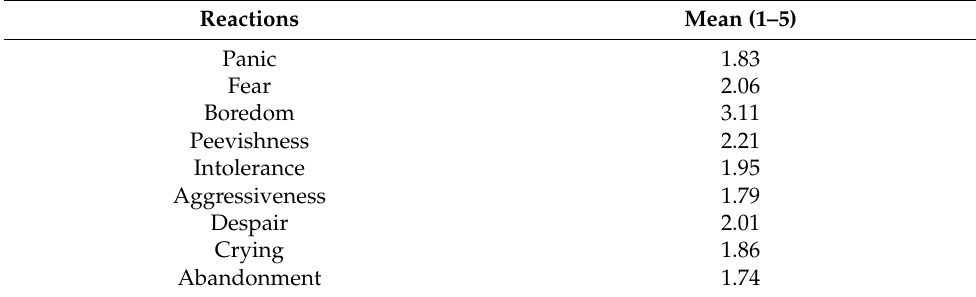
Table 5. Emotional reactions during the state of